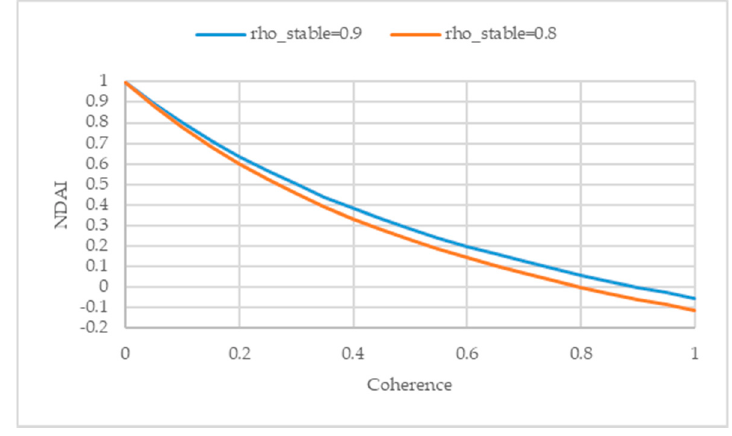
Figure 7. NDAI as a function of coherence.